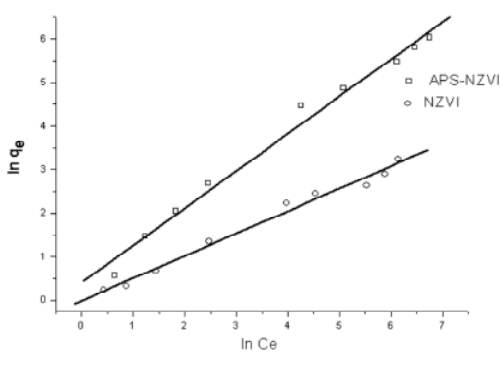
Figure 7. Freundlich isotherms for the adsorption of